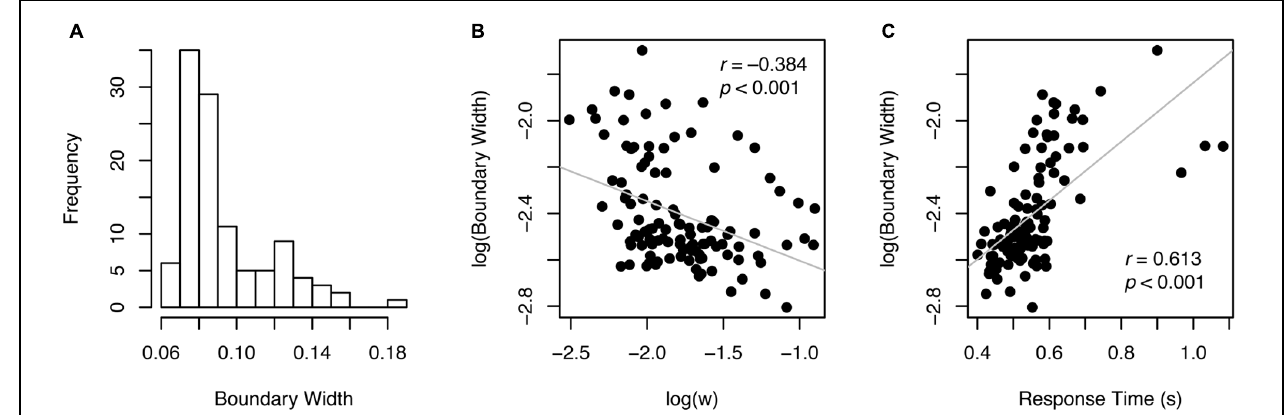
FIGURE 5 | Boundary width (A) and its relationship with w and RT (B,C).